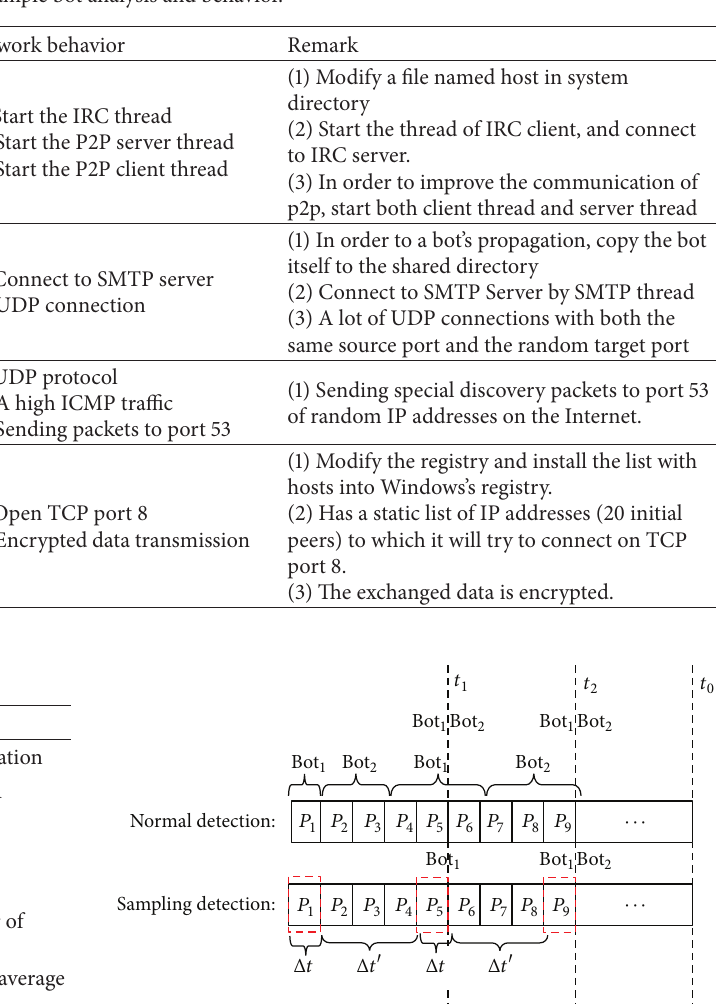
Table 1: Sample bot analysis and behavior.